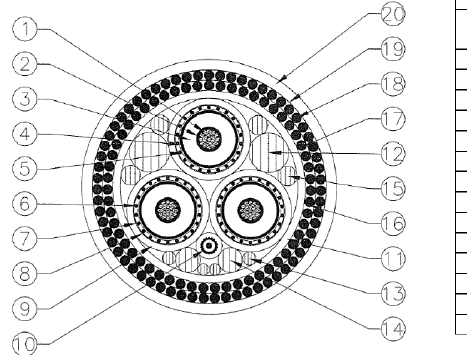
Figure 12. Cross section of a three phases DSEC.